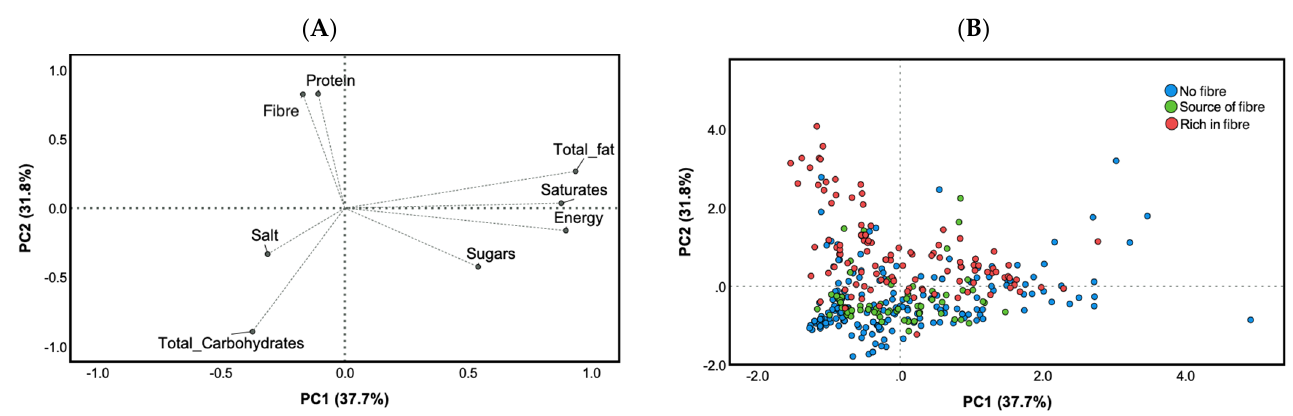
Figure 2. Principal component analysis (PCA) describing the intra-category variability of products based on their nutrient composition (energy (kcal/100 g), total fat (g/100 g), saturates (g/100 g), total carbohydrates (g/100 g), sugars (g/100 g), protein (g/100 g), fibre (g/100 g) and salt (g/100 g)). Loading plots of Principal Component (PC) 1 and 2 ( A ) and score plots of the nutrient composition of each product analysed organised according to presence and kind of fibre-related claim from PC1 and PC2 ( B ).